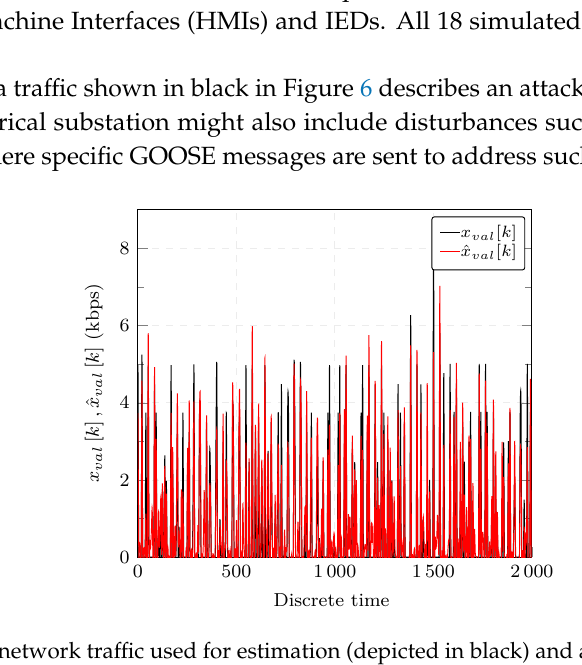
Figure 6. GOOSE network traffic used for estimation (depicted in black) and arfima model prediction (depicted in